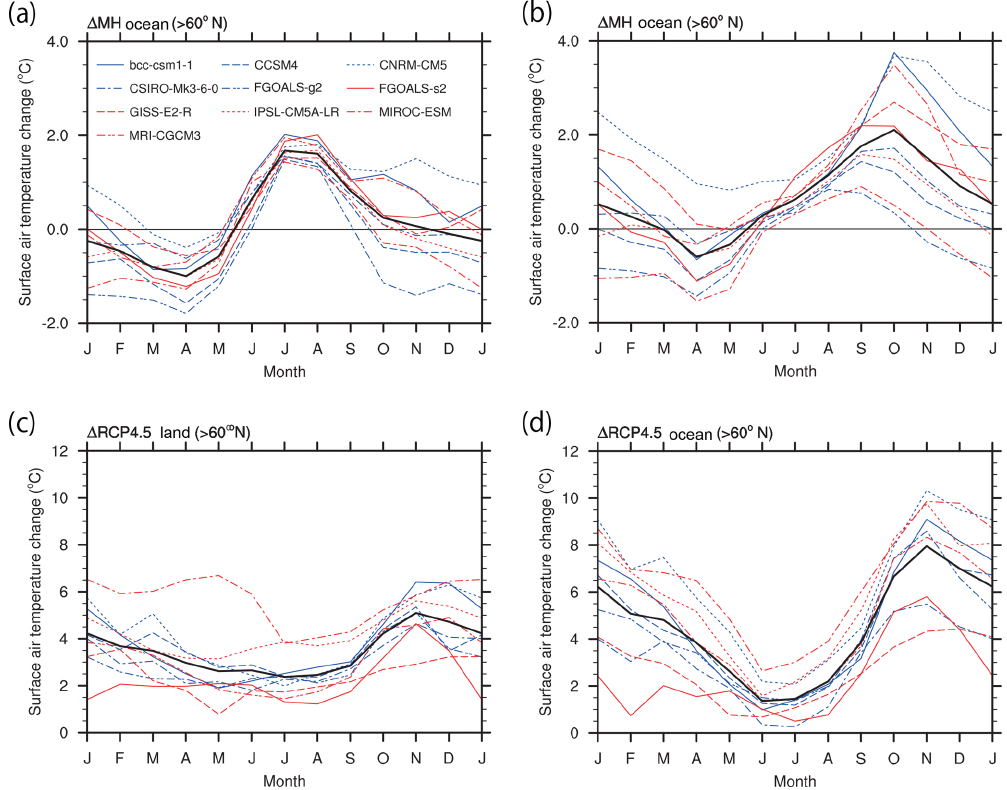
Figure 3. Seasonal progress of the surface air temperature change ( ◦ C) in the Arctic (north of 60 ◦ N): (a) (cid:49) MH land; (b) (cid:49) MH ocean; (c) (cid:49) RCP4.5 land; and (d) (cid:49) RCP4.5 ocean. Thick black lines show the multi-model mean. Note that the range of vertical axis is different for (cid:49) MH (a, b) and (cid:49) RCP4.5 (c, d)